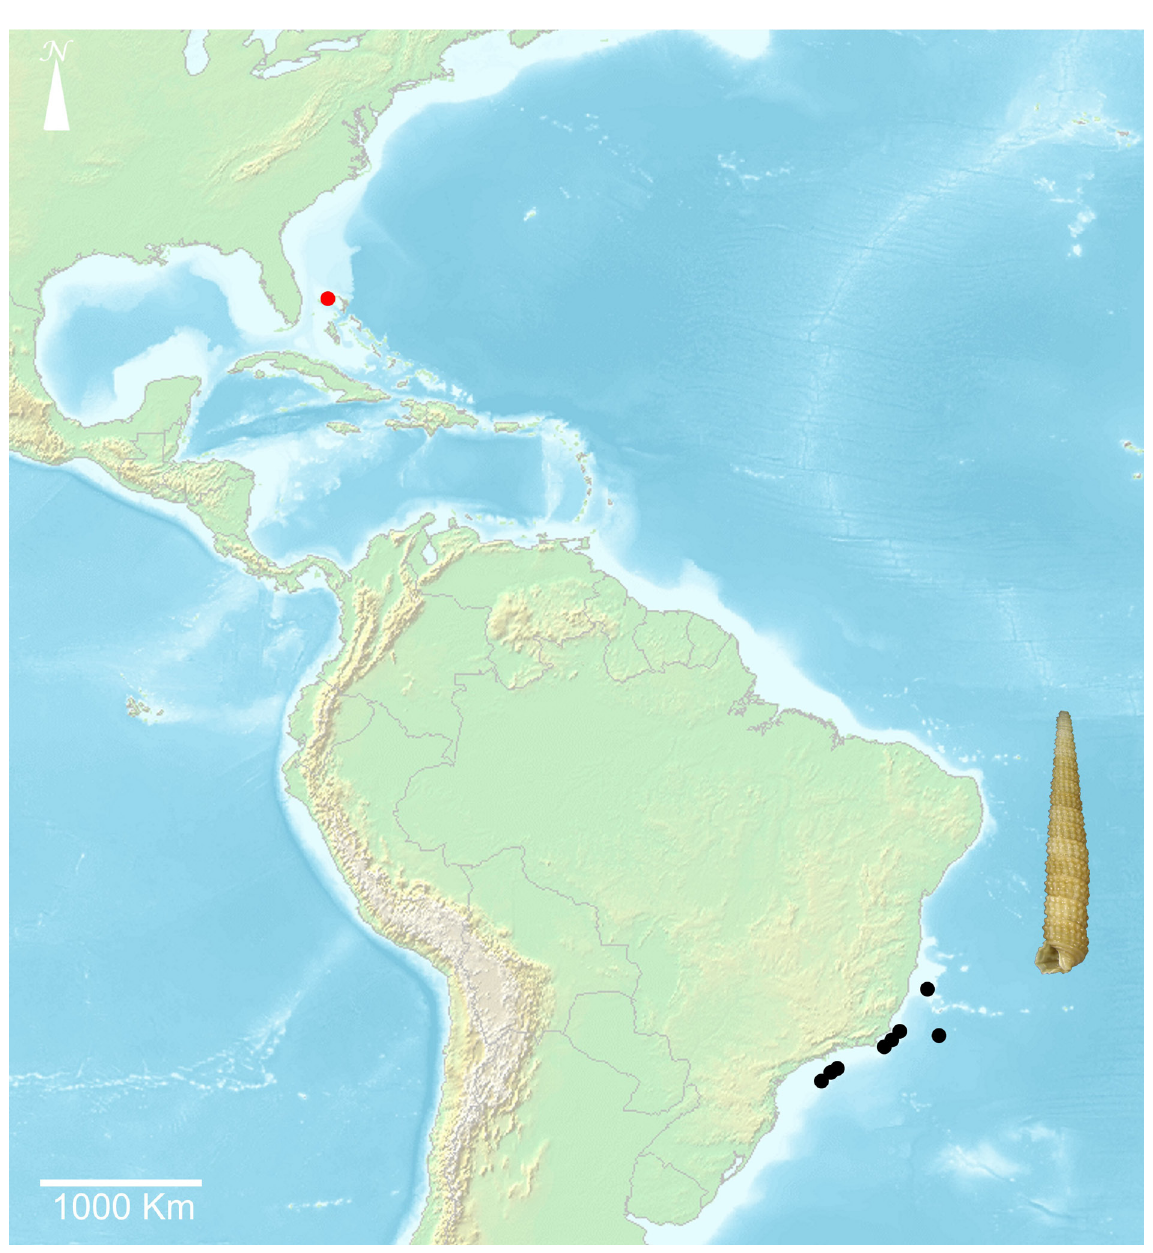
Fig. 35. Distribution map of Inella apexbilirata Rolán & Fernández-Garcés, 2008; red circle = type